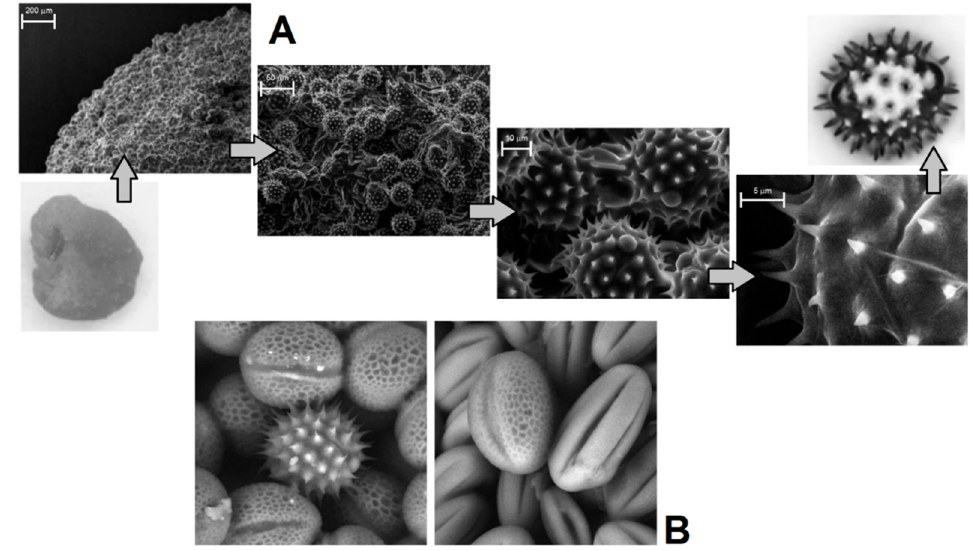
Figure 1. Light microscopic and SEM images of bee pollen: from load to grain ( A ); SEM detection of pollen inhomogeneity ( B ).